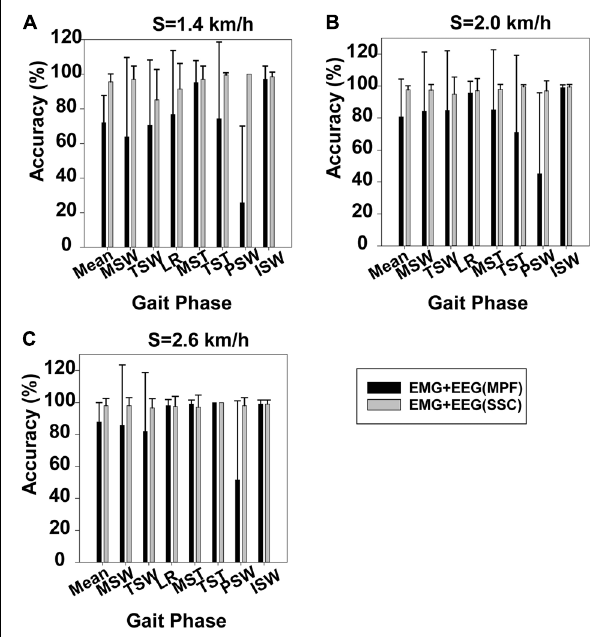
FIGURE 3 | Gait phase recognition results based on case 1 and case 2. (A) Walking speed 1.4 km/h, (B) walking speed 2.0 km/h, and (C) walking speed 2.6 km/h. The blue column indicates that the results based on case 1 are better than those on case 2.